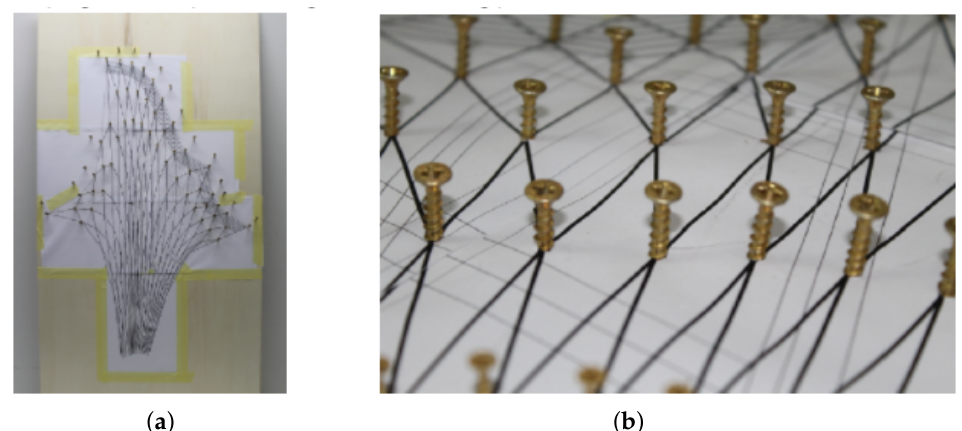
Figure 12. Templates ( a ) The printed template attached to a wooden board. ( b ) Close up showing various lineweights and pins.